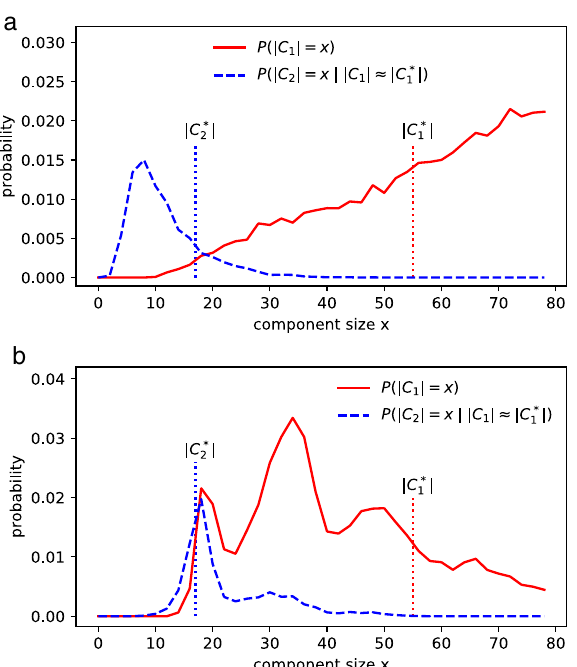
Figure 7. Fitting ER and PARG to the observations ( | C ∗ 1 | =55, | C ∗ 2 | =17) in Tianjin. Both models contain 136 nodes and run 20,000 random realizations. ( a ), ER model contains 95.2 edges. It reaches the maximum similarity ( T duo =0.0161) when p = 1.41 / n . ( b ), G ( 7.20 179 , 1.90 / n ) contains 128.2 edges and has a much higher similarity T duo